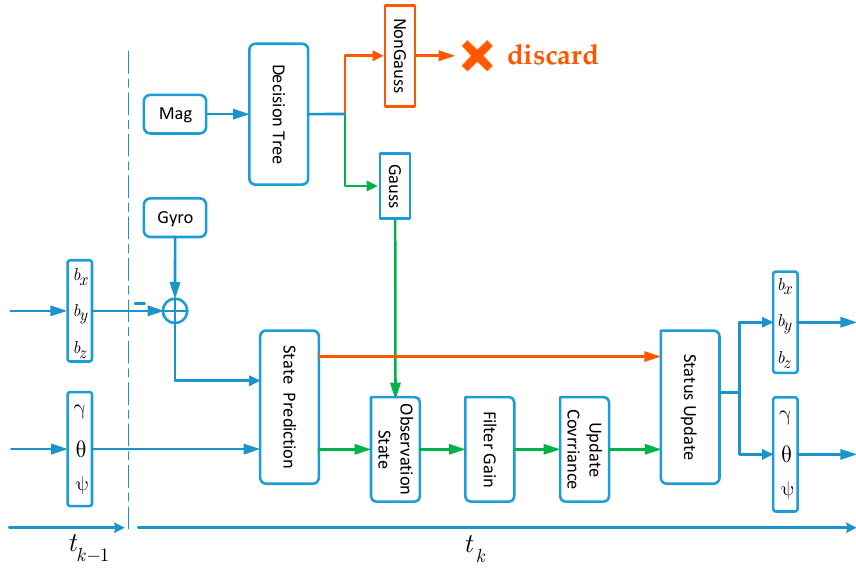
Figure 7. Flow chart of the proposed algorithm.